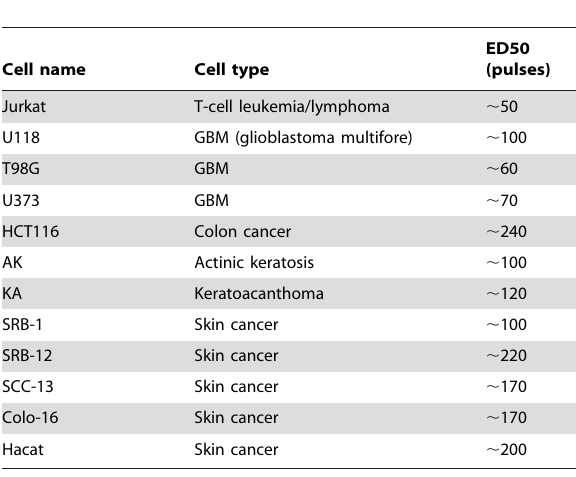
Table 2. Sensitivity of different cell types to cell death (ED50) caused by nsPEF (30k